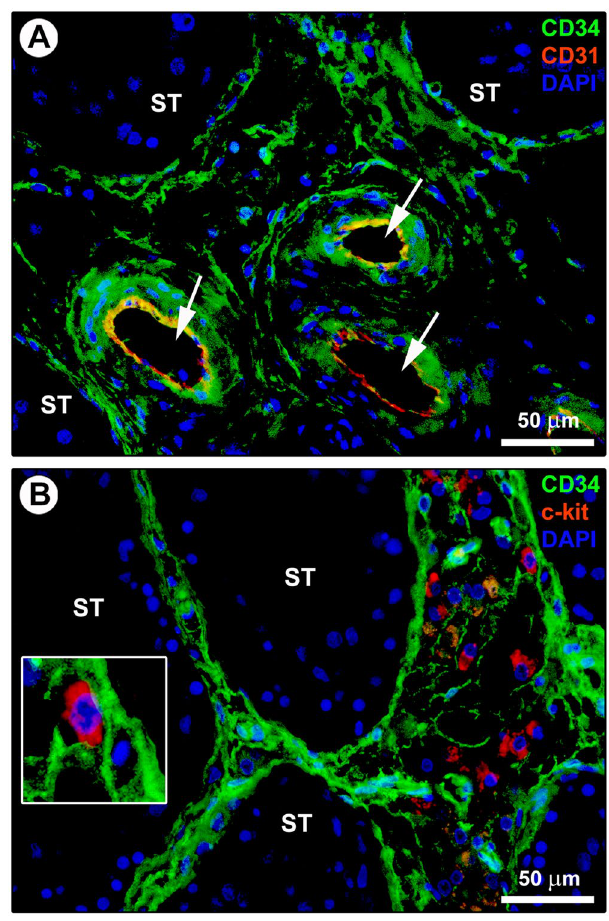
Figure 2. Double immunostaining of human testis sections. ( A ) Representative photomicrograph of immunofluorescence labeling for CD34 (green) and CD31 (red) with 4 ′ ,6-diamidino-2-phenylindole (DAPI; blue) counterstain for nuclei. The CD34-positive interstitial cells surrounding the seminiferous tubules (ST) and forming a reticular network in the intertubular stromal tissue lack CD31 immunoreactivity. The endothelial cells lining the lumen of microvessels (arrows) are CD34-positive/CD31-positive. ( B ) Representative photomicrograph of immunofluorescence labeling for CD34 (green) and c-kit/CD117 (red) with DAPI (blue) counterstain for nuclei. The CD34-positive interstitial cells distributed in the peritubular and intertubular stroma are immunophenotypically negative for c-kit/CD117. Immunoreactivity for c-kit/CD117 is detected in oval/round-shaped cells, presumably Leydig cells and/or mast cells, surrounded by the network of CD34- positive interstitial cells. A higher magnification of a c-kit/CD117-positive cell embraced by the cytoplasmic processes of CD34-positive interstitial cells is depicted in the inset. Scale bar: 50 µ m ( A,B